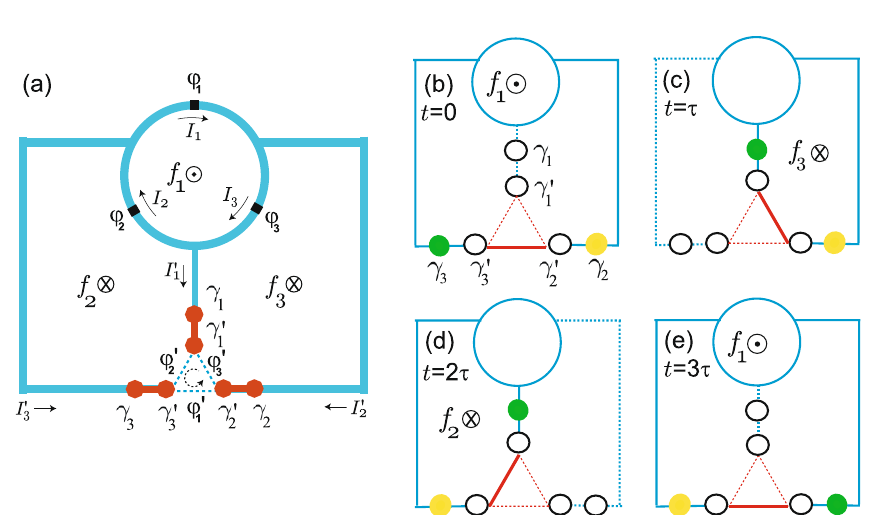
Figure 4. ( a ) Three MZM (red circle) pairs are introduced at the end of branches where three MZMs, γ ′ i , are coupled through a Josephson trijunction. Braiding sequence of system in ( a ): by applying adiabatically the fluxes ( b ) f 1 , ( c ) f 3 , ( d ) f 2 , and finally ( e ) f 1 again, the green and yellow MZMs are exchanged with each other to complete a non-Abelian braiding procedure. In the branches represented as dotted line there is no current flowing. In trijunction thick red line corresponds to a large current amplitude of I i